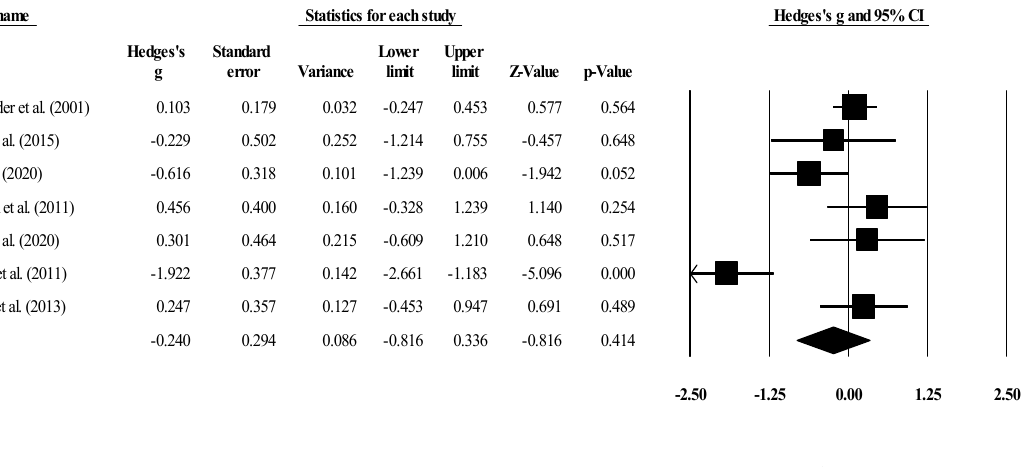
Figure 6. Forest plot of changes in hip flexion ROM after participating in stretching-based compared to strength-based training interventions. Values shown are effect sizes (Hedges’s g) with 95% confidence intervals (CI). The size of the plotted squares reflects the statistical weight of the study.